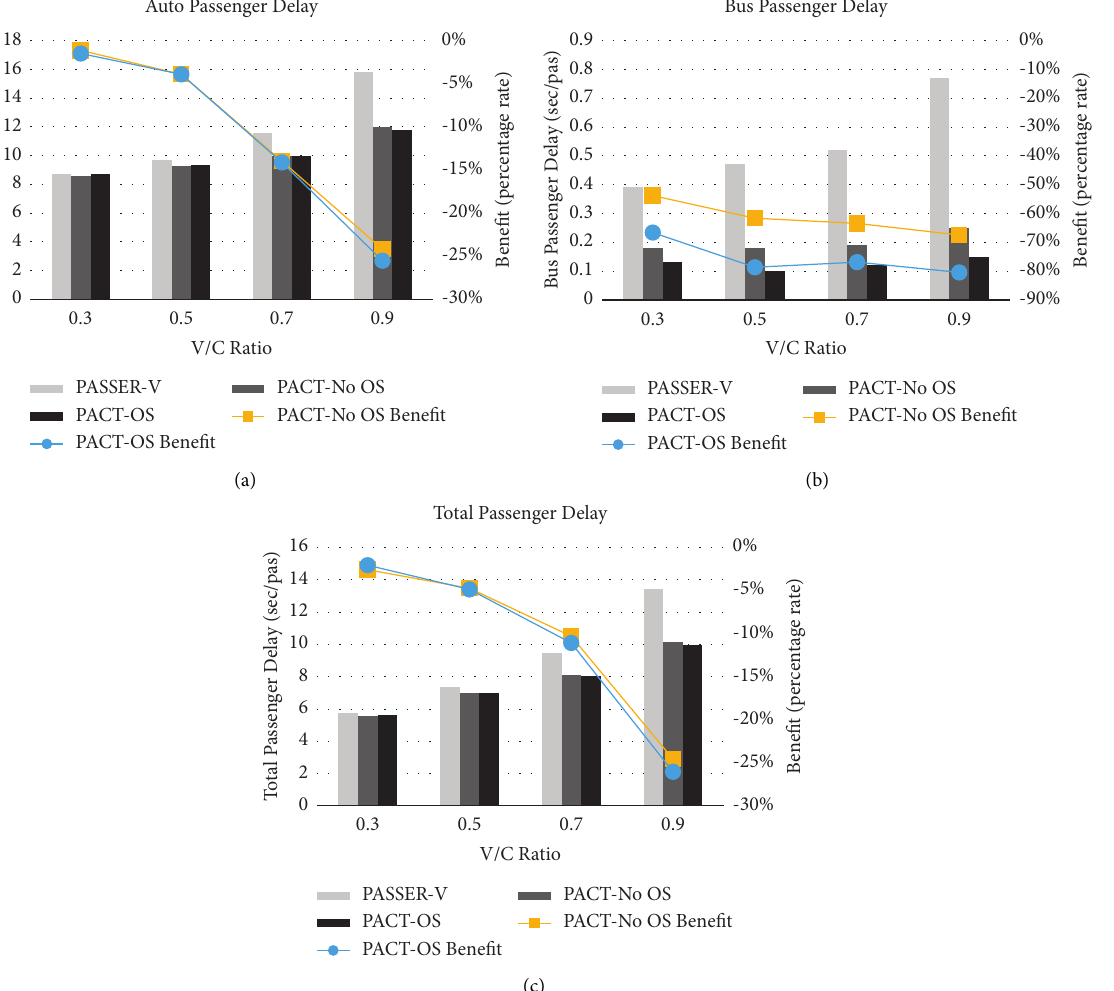
Figure 12: Delay changes in (a) auto passenger, (b) bus passenger, and (c) total passenger under various V/C